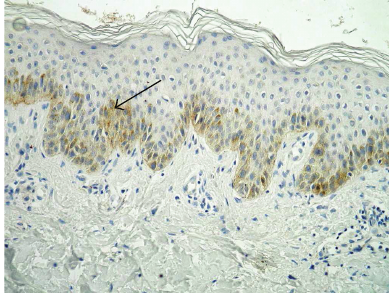
Figure 7: Skin lesions in BP, immunohistochemistry. Strong ex- pression of E-selectin on endothelial cells (original magnification